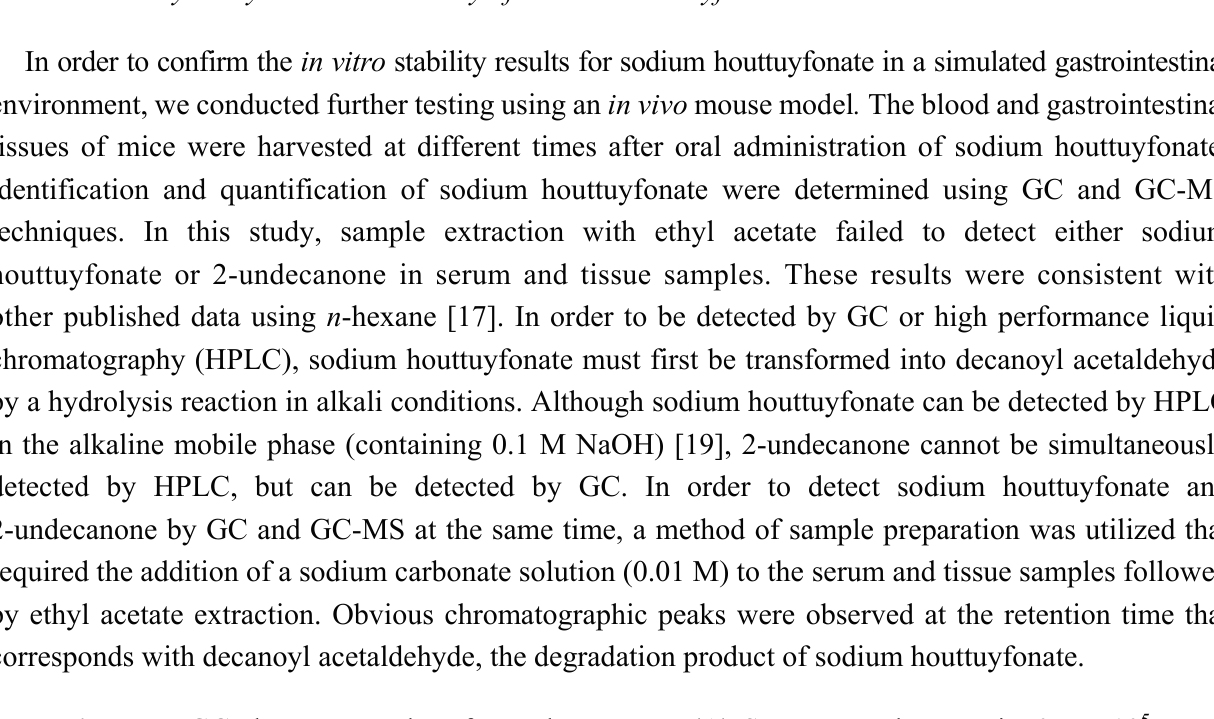
Figure 7. GC chromatography of samples in vivo . ( A ) Serum samples, y -axis: 0.7 × 10 5 ; ( B ) samples of stomach, y -axis: 1.0 × 10 5 ; and ( C ) samples of intestine, y -axis: 0.3 × 10 5 . 1, sodium houttuyfonate; 2,